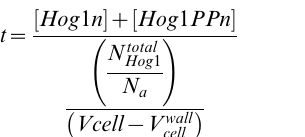
Figure S1 Comparison of model fit to the data of glycerol change under square pulse 0.5 M NaCl (T on = T off = 30 min). Figure S2 Comparison of model predictions to experimental data of Hog1 nuclear enrichment under periodic square pulse of 0.2 M NaCl. Blue curves: model prediction results. Red square points: experimental data from Fig. S4 of the reference (Mettetal et al. , Science, 2008, 319: 482–484). For ‘‘low Pbs2’’ mutant, the model set Pbs2 concentration to be 12.55% of the corresponding Pbs2 in ‘‘wild-type’’. Figure S3 Model predictions of Hog1 phosphorylation response to step increase of 0.2 M NaCl in different low expression level of Pbs2 mutants. Figure S4 Model predictions for Hog1 phosphorylation re- sponse to different double step increases of 0.5 M NaCl. (A) Double stress profile. (B–D) Black curves corresponding to Hog1 phosphorylation response to normal step increase of 0.5 M NaCl (single stress). Blue curves are the model predictions for Hog1 phosphorylation response to double stresses (The second stress added at different times). The Hog1 phosphorylation level is normalized to its maximum level in single stress.